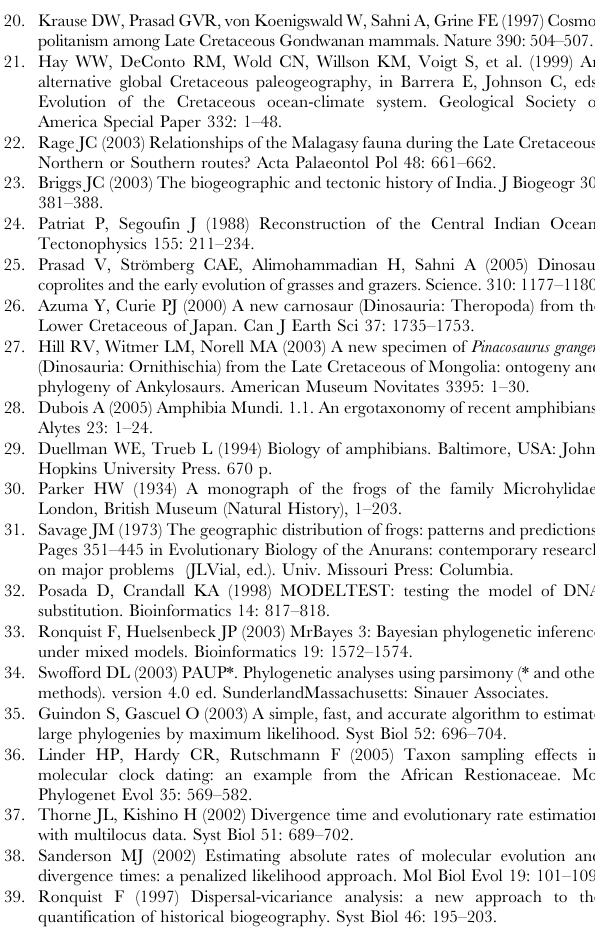
Table S10 Dating estimates (mya) for Microhylidae and Natatanura, with DIVA reconstruction of vicariance events in their early evolution. For both the TK- and PL-method, the ages represent the 95% confidence intervals of the analysis that includes all calibration points except G. Vicariance (1) represents the strict